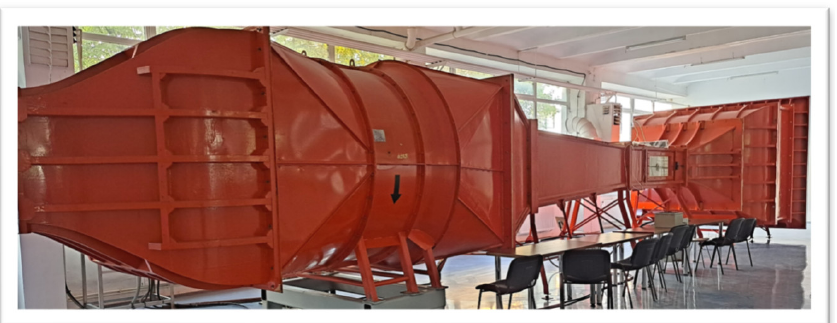
Figure 4. Wind tunnel natural